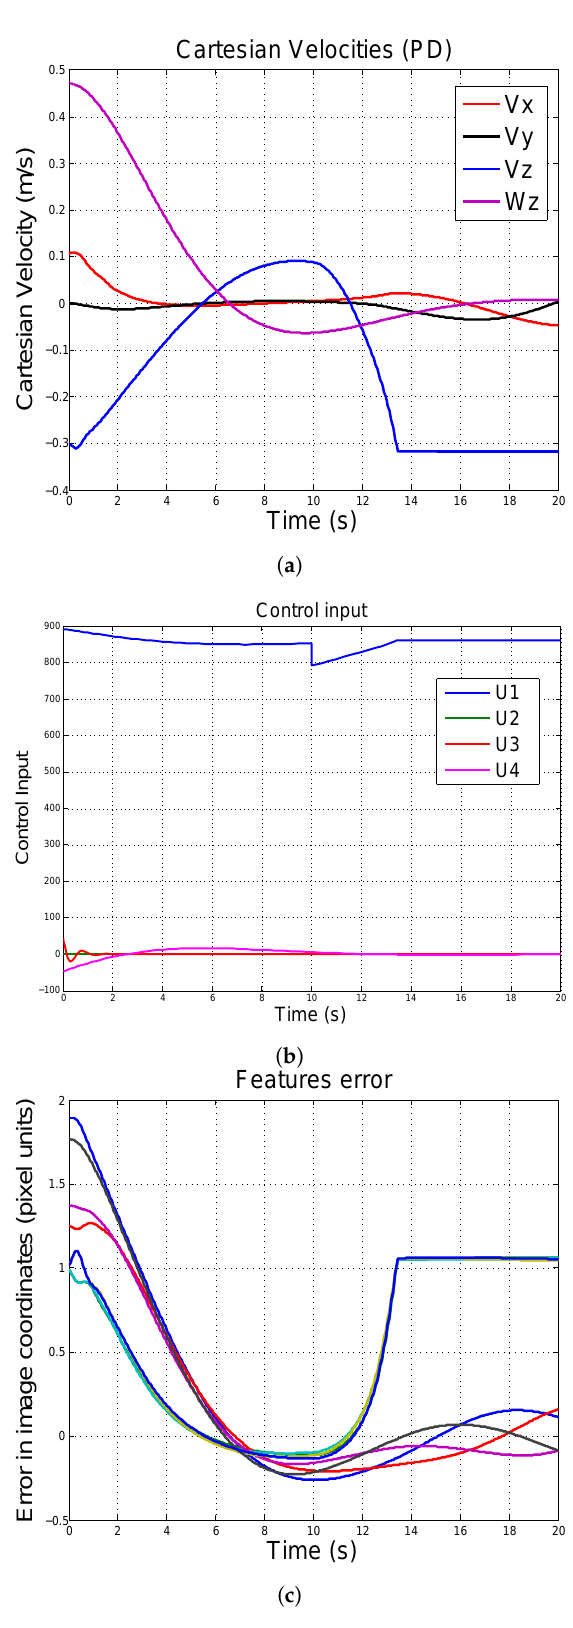
Figure 6. Simulation using conventional PID. At 10 s, the mass of the system is incremented 50% and λ = 0.3. ( a ) Cartesian velocities; ( b ) control input; ( c ) features